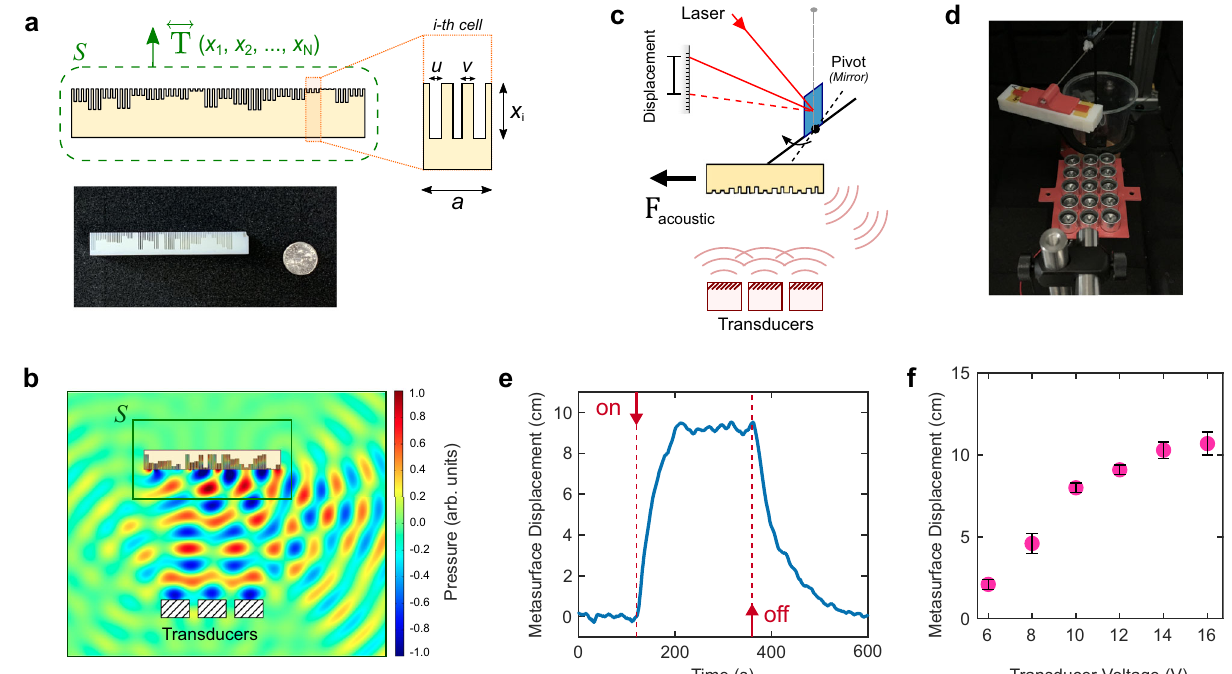
Fig. 2 | Design of the acousto-mechanical metasurface and the demonstration of actuation. a The building-block unit cell with variable depth (inset). The meta- surface is optimized to induce a strong lateral force parallel to its long side, as derivedfromthepressuretensor T .Below:fabricatedmetasurface(adimeisshown for scale). b Scattering pro fi le for the incident inaudible acoustic wave (20kHz) showing the momentum fl ow to the right.Boxindicates the enclosing surface over